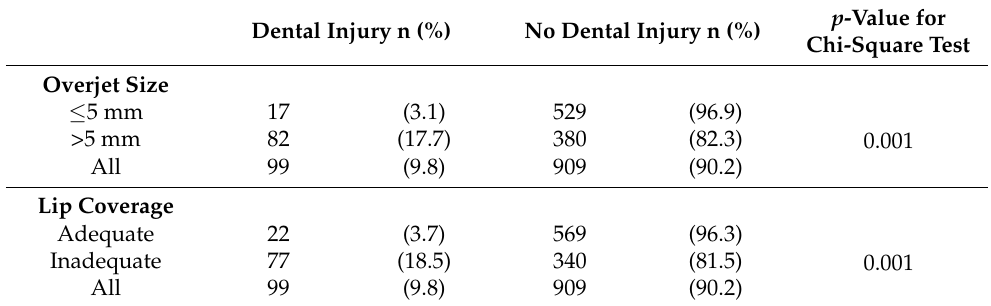
Table 2. Distribution and prevalence of permanent incisor dental injuries by overjet size and lip coverage.